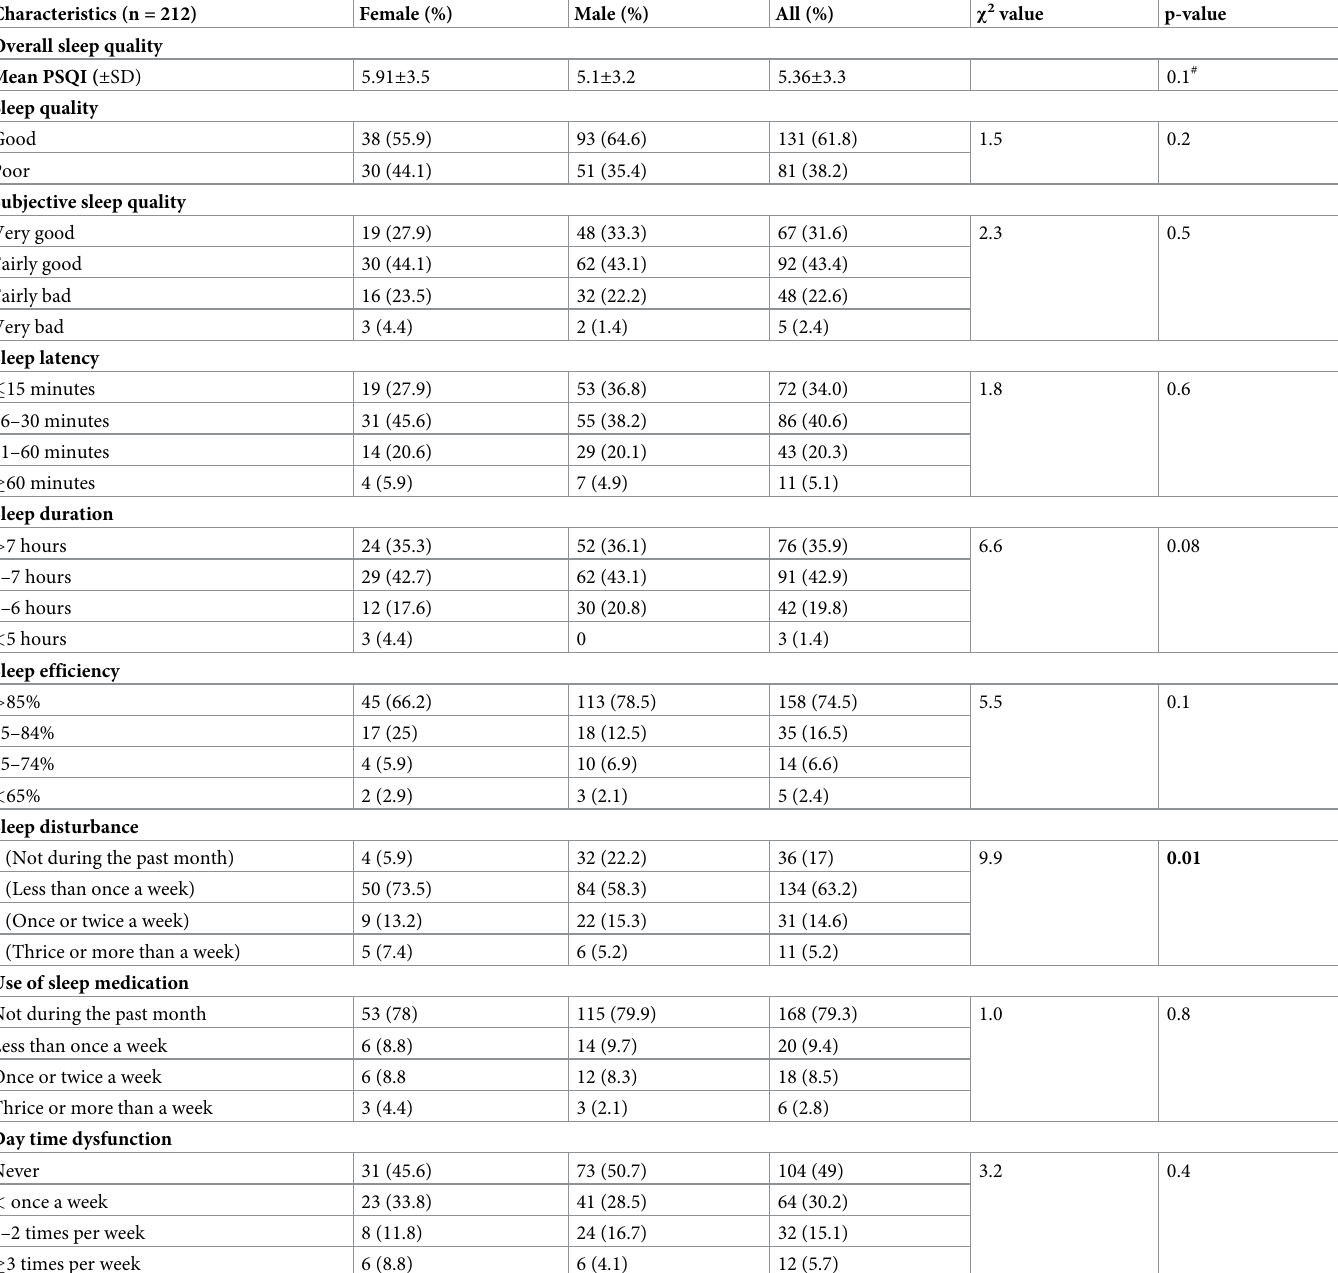
Table 3. Sleep quality and sleep patterns overall stratified by gender. Characteristics (n =